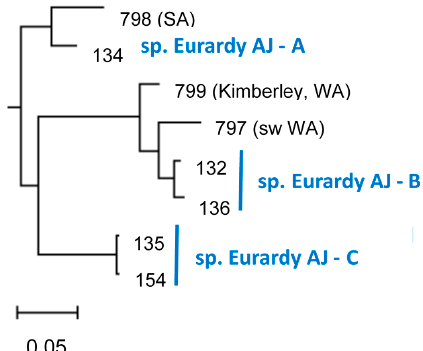
Figure 9. Extract from the full CO1 tree (Figure S1)—II. The clade represents species from the M. ludius group with reddish head and mesosoma and contrasting black gaster. Specimens sorted as Melophorus Eurardy sp. AJ ( ludius gp.) appear to represent three species (A–C), all from Eurardy Station in Western Australia. SA = South Australia; WA = Western Australia.